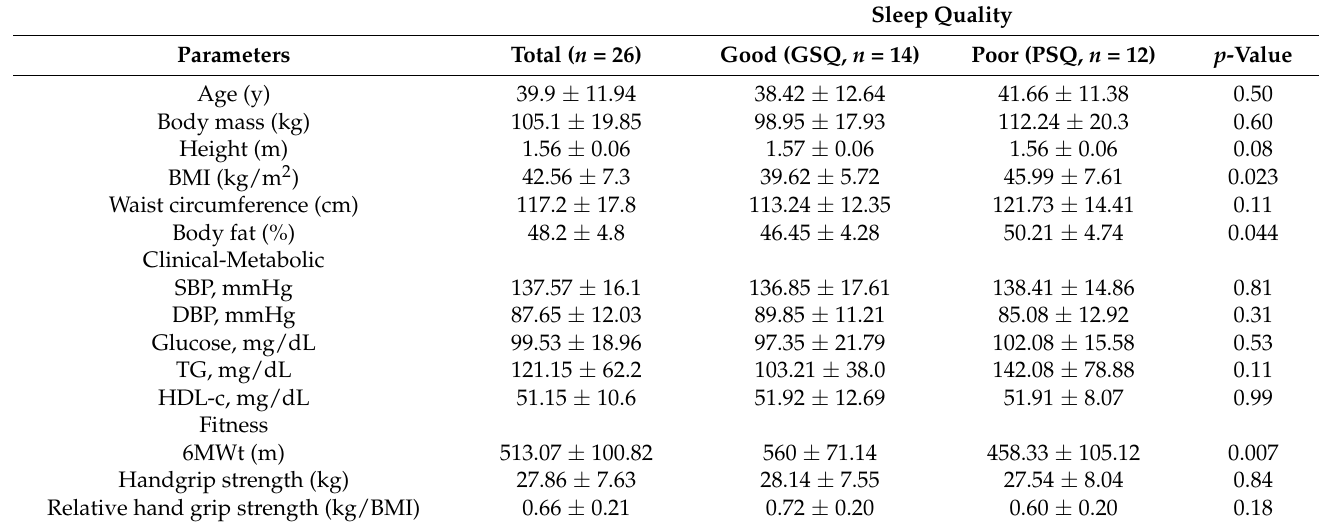
Table 1. Anthropometric, clinical-metabolic and fitness characteristics of the study population according to sleep quality.